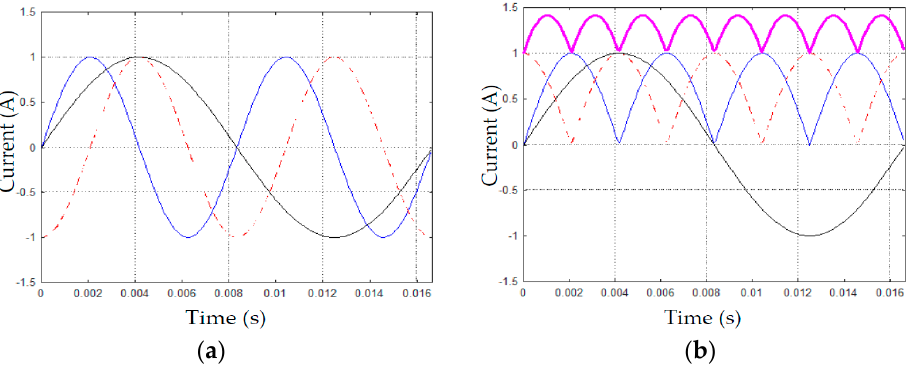
Figure 4. Transformation of signals during signal processing in the proposed DC offset compensation algorithm. ( a ) Fundamental and the second harmonic signal extracted by the SOGI; ( b ) Absolute signals of second harmonic signal and its 90 degree shifted signal. Eighth order signal generated by adding second harmonic signal and its 90 degree shifted signal.